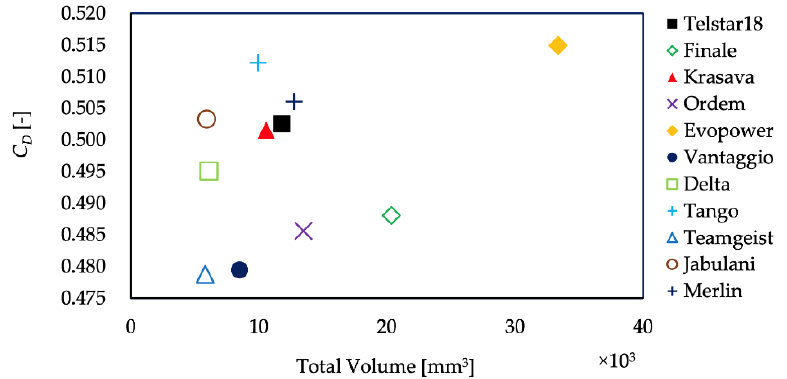
Figure 12. The relationship between groove volume and drag coefficient ( C D ) in the subcritical re-